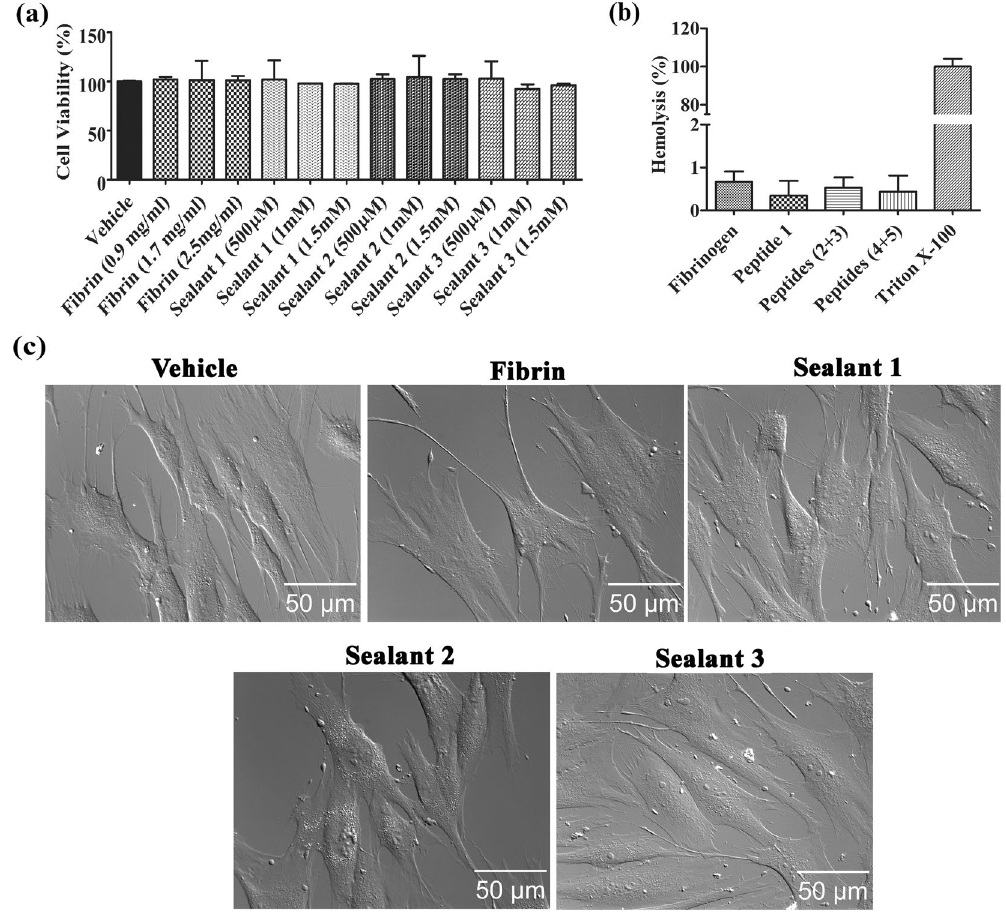
Figure 4. ( a ) MTT assay of sealants against human fibroblasts cells, ( b ) hemolysis assay of peptide mixtures against blood cells (chicken) and ( c ) DIC images of human fibroblast cells in presence of sealants. Scale bar of the DIC images are 50 μ